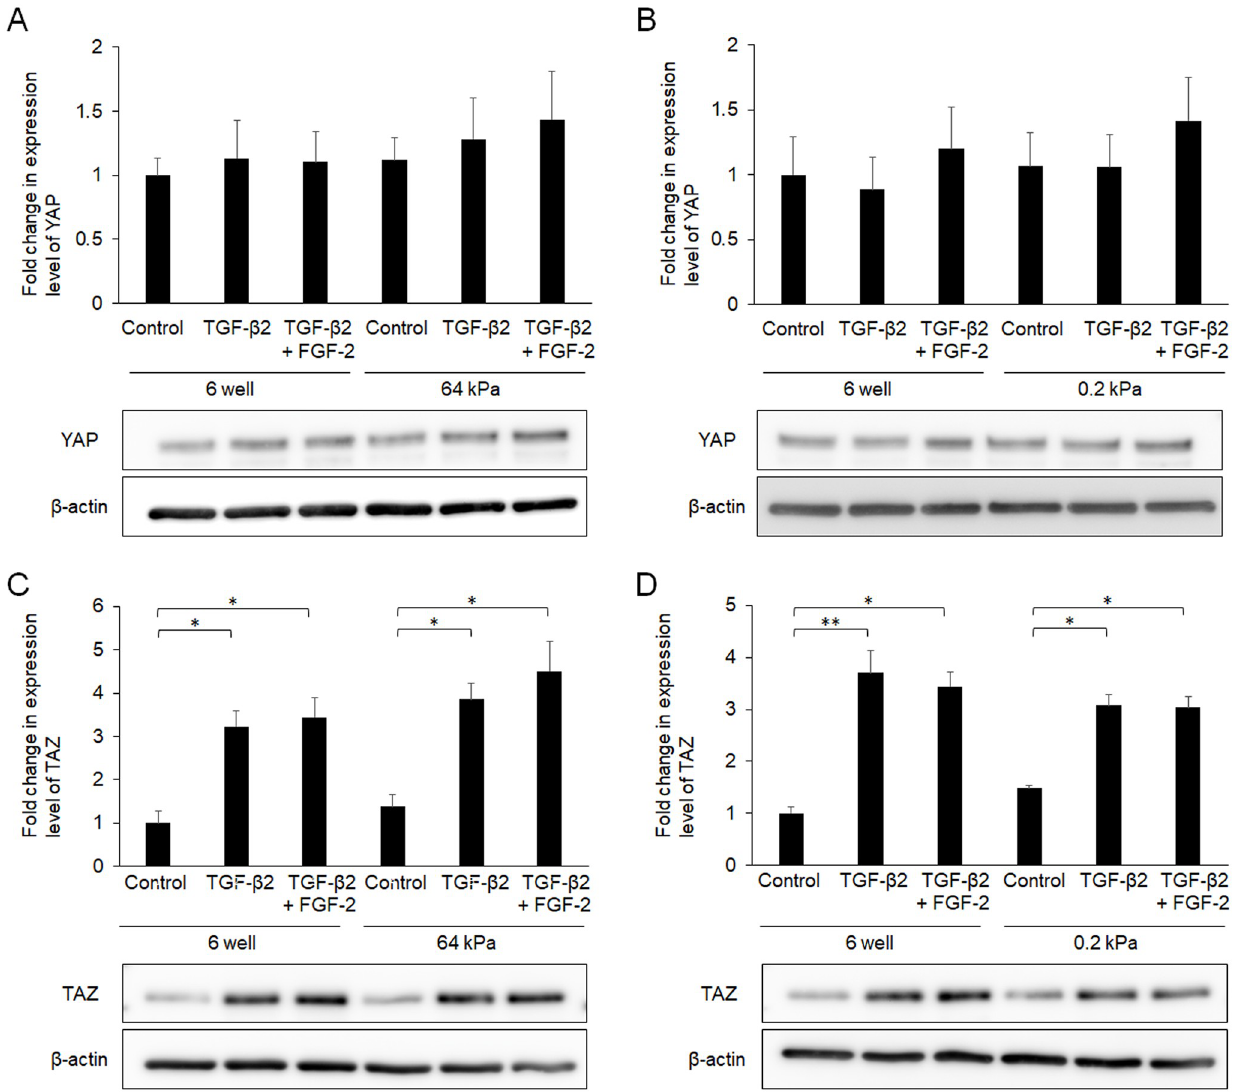
Fig 6. Effects of FGF-2 and/or soft substratum on the expression of YAP (A) and TAZ (B). Conjunctival fibroblasts were cultured on normal plastic wells or soft substratum wells (64 or 0.2 kPa), and treated with FGF-2 (10 ng/mL) and/or TGF- β 2 (2.5 ng/mL) for 24 h, followed by Western blot analysis. The expression levels of YAP or TAZ were not affected by the stiffness of the substratum. � p < 0.05, �� p < 0.01. Data are shown as the mean ± SE, n =